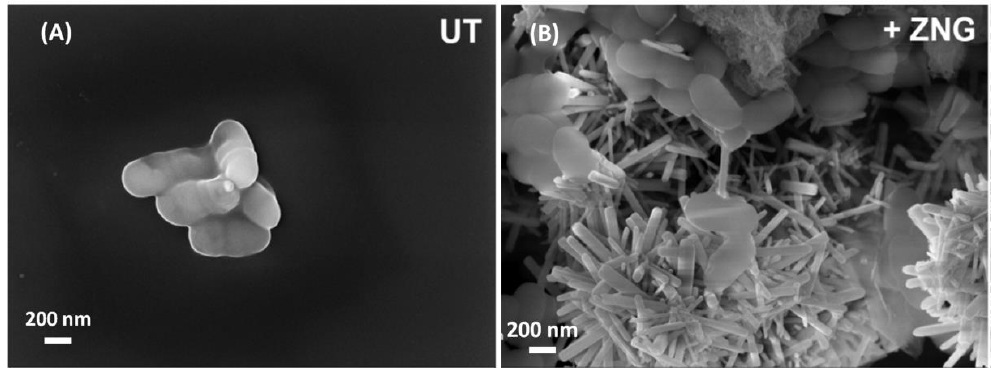
Figure 7. FE-SEM micrographs of S.mutans cells; ( A ) untreated and ( B ) treated with ZNGs suspension (50 µg/mL) for 24 h.